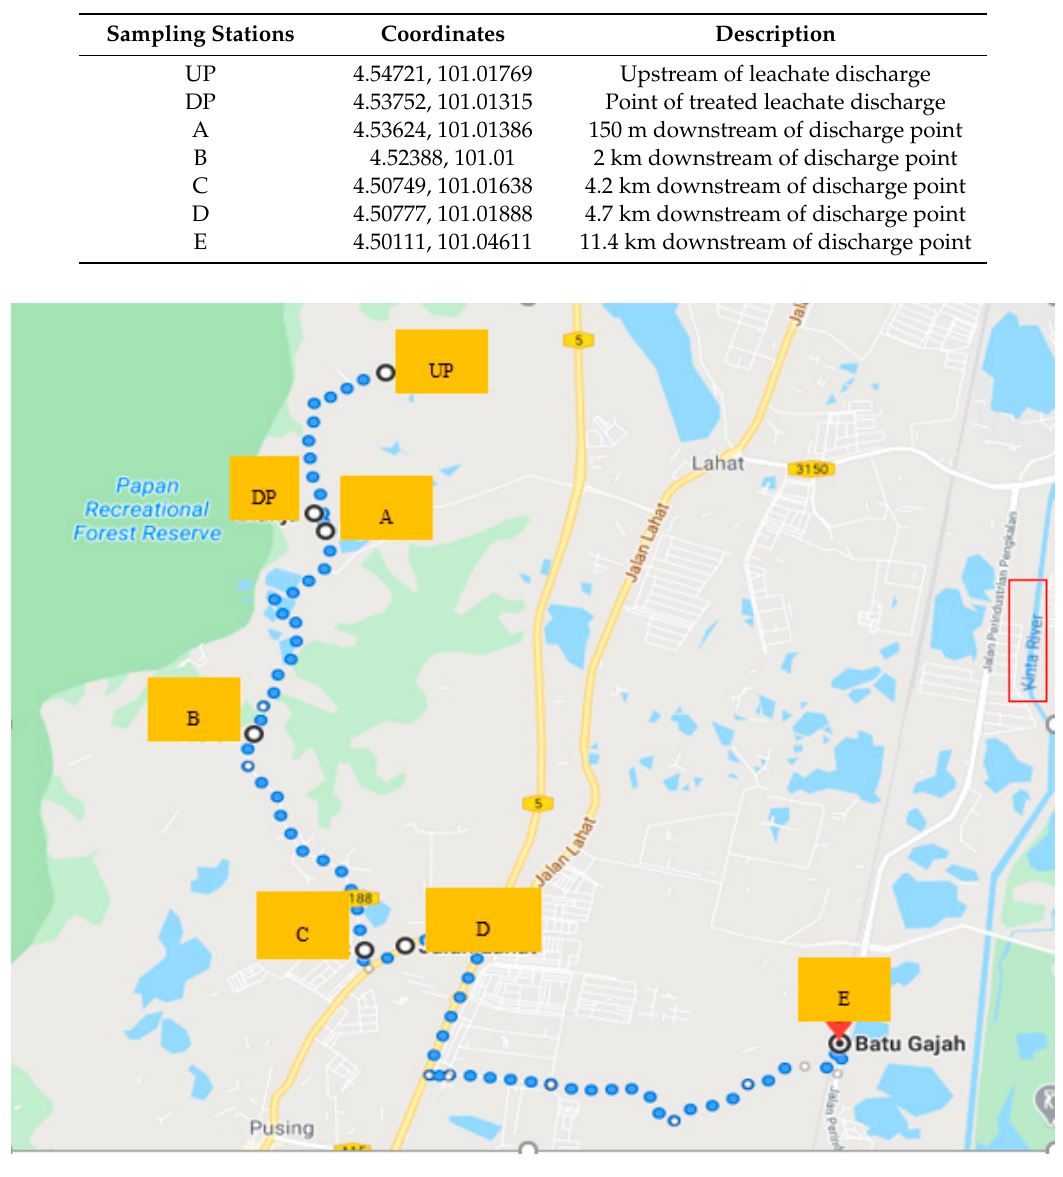
Table 3. Location of sampling stations.